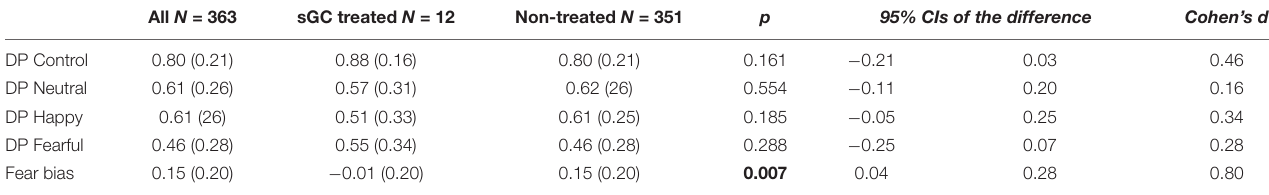
TABLE 2 | Eye-tracking results (mean, SD).